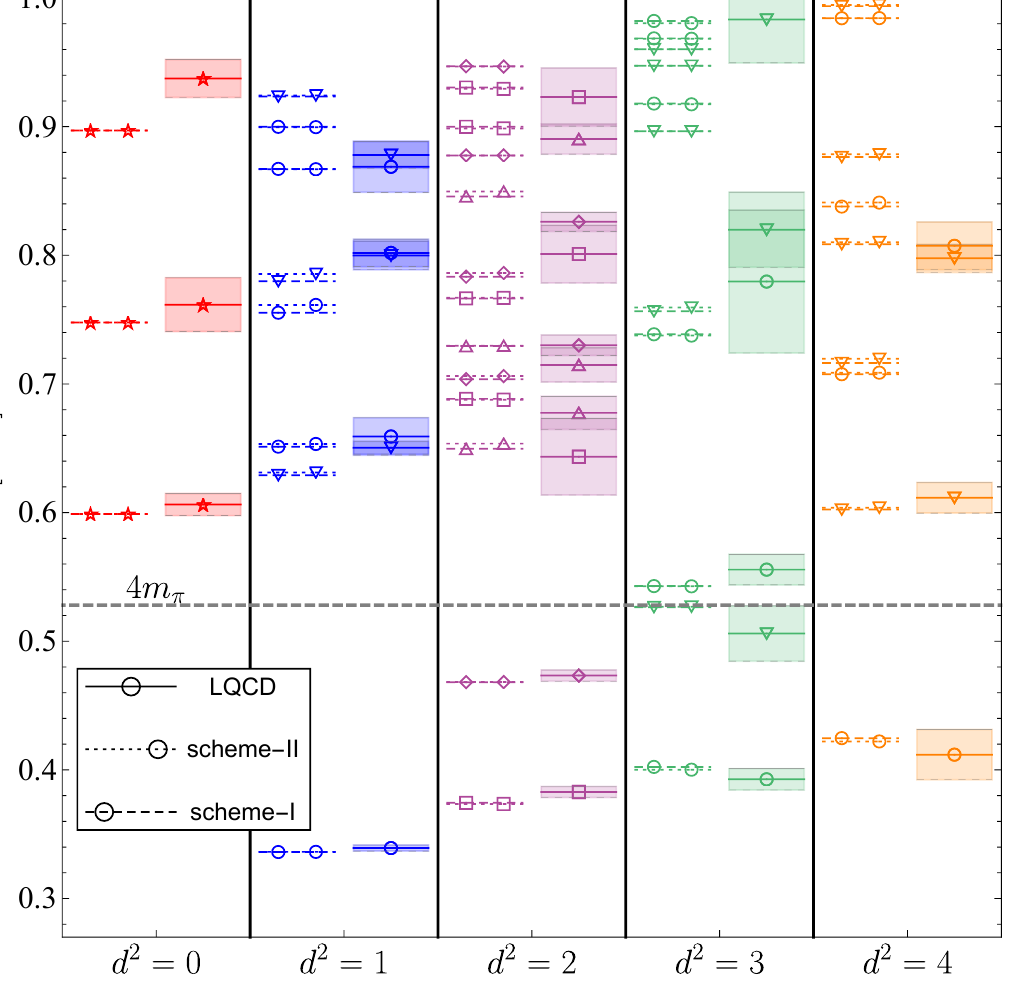
Figure 13 . Comparison of the FV energy levels from lattice QCD and our calculations using the two different schemes for discretizing the momenta in the moving frames as explained in section 2.2. The notation for various symbols is the same as those in figure 12. The uncertainties of the lattice QCD data are taken from ref.